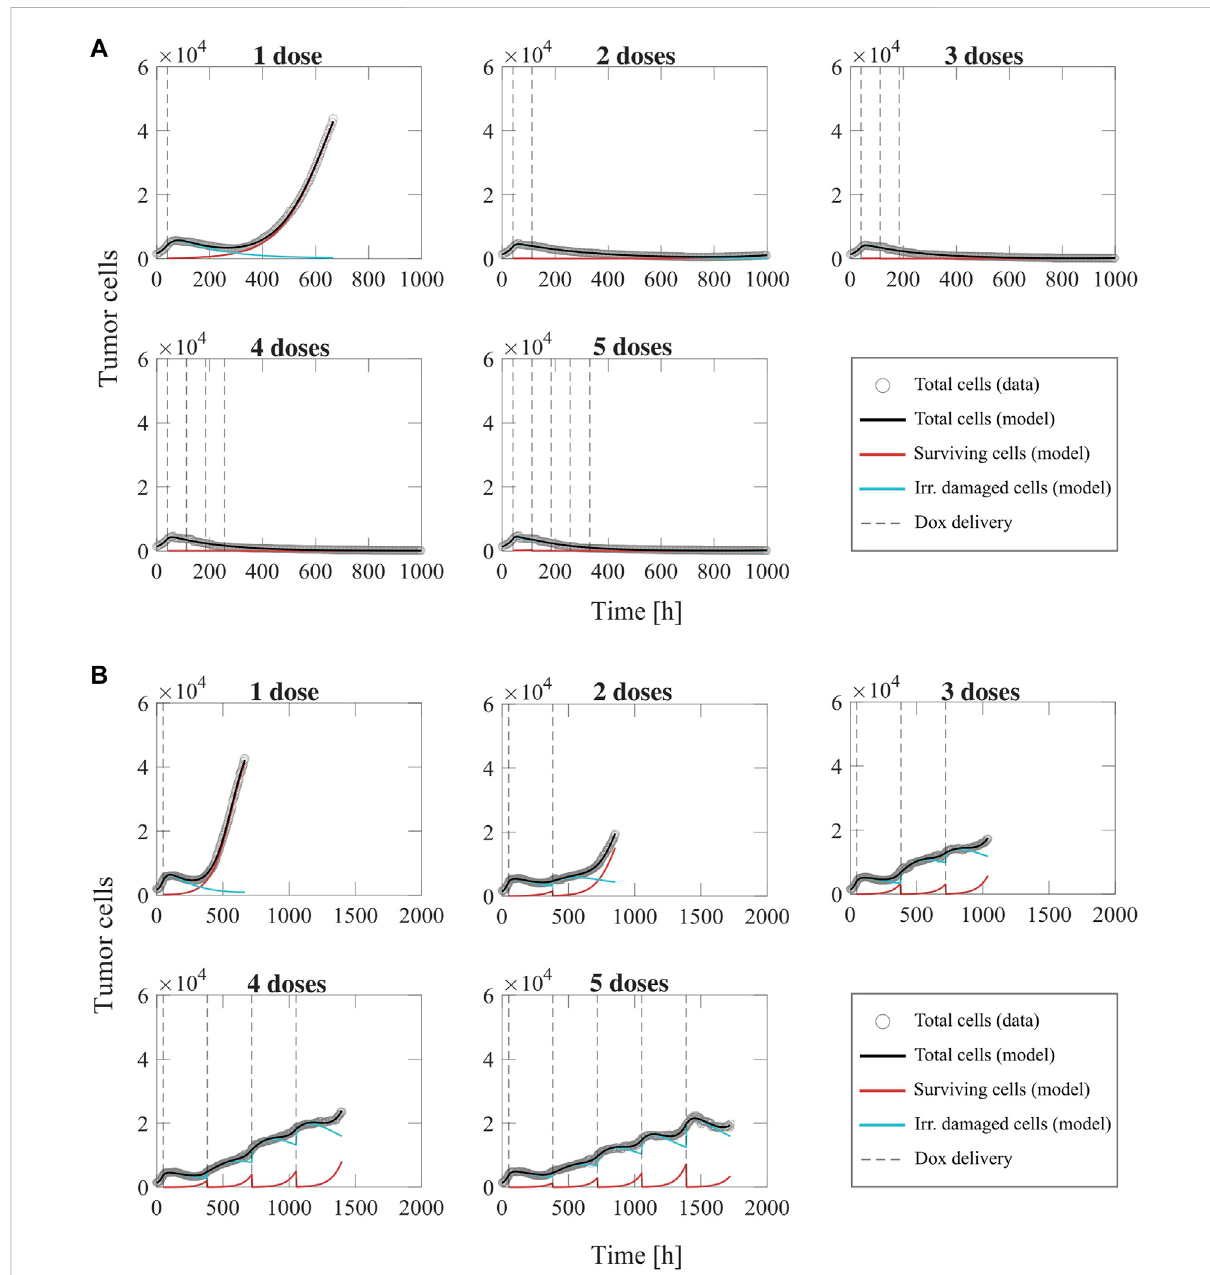
FIGURE 8 Representative fi ts of the multiple-dose model for a varying number of doxorubicin doses. Data and model results are shown for a representative replicate treated with 1 – 5 doses of 75 nM doxorubicin delivered at either 2-day or 2-week inter-treatment intervals (Experiment 3, Table 1).Experimentaldata areshowningraycircles. The numberoftotalcells, surviving cells, and irreversiblydamagedcellsobtained with the fi tted multiple-dose model are shown in black, red, and blue solid lines, respectively. The times at which doxorubicin (Dox) is delivered are representedwithvertical greydashedlines.Panel (A) shows fi ttingsfor1to5doxorubicindosesdeliveredat2-dayinter-treatmentintervalsobtained with the model with constant parameters. The median and range of the quality of fi t metrics across all replicates for this Experiment 3 subgroup ( n = 60, Table 1) are NRMSE: 12.2 [2.72, 19.1], R 2 : 0.99 [0.87, > 0.99], PCC: 0.99 [0.93, > 0.99], CCC: 0.99 [0.93, > 0.99]. Panel (B) shows fi ttings for 1 to 5 doxorubicin doses delivered at 2-week inter-treatment intervals obtained with the model with varying f s and γ d . The median and range of the quality of fi t metrics across all replicates for this Experiment 3 subgroup ( n = 60, Table 1) are NRMSE: 3.21 [1.91, 8.57], R 2 : > 0.99 [0.93, > 0.99], PCC: > 0.99 [0.97, > 0.99], CCC: 0.99 [0.96, > 0.99]. Overall, we observe that there is superior tumor control with an increased number of doses, which is further improved when the doses are delivered at shorter inter-treatment intervals. As the inter-treatment interval is lengthened from 2 days to 2 weeks, weobserve thatthepopulationgrowth rate andnumber ofthesurviving cells increase,while theirreversiblydamagedcellsexhibitaslower transition from proliferation to treatment-induced